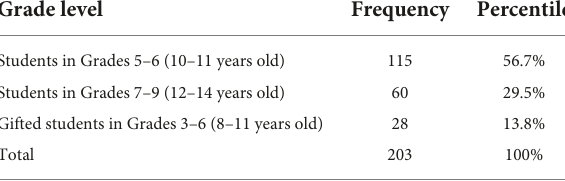
TABLE 1 Distribution of filmed pairs by grade level.